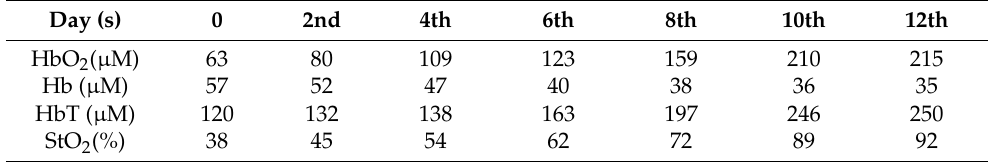
Figure 3. An example of stimulated squamous cell carcinoma on the buccal mucosa in image of OCT concept ( A ), under white light ( B ), and 3 h after intravenous application of Photofrin ® during PDT of tumor ( C ); the tumor area is marked with the symbol (*). Table 1. Mean changes in intrinsic signals based on time during tumor